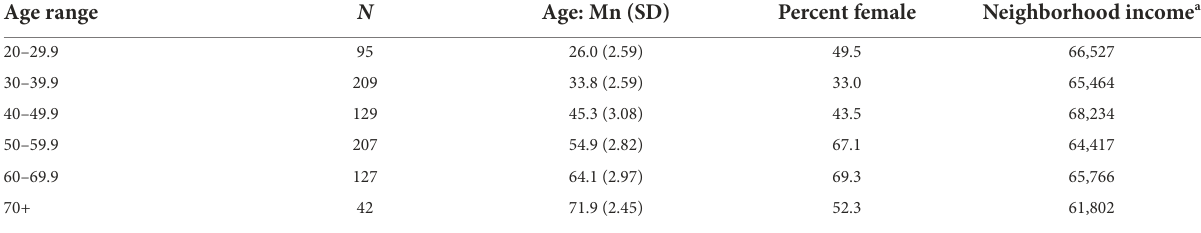
TABLE 1 Age, number, gender, and income of